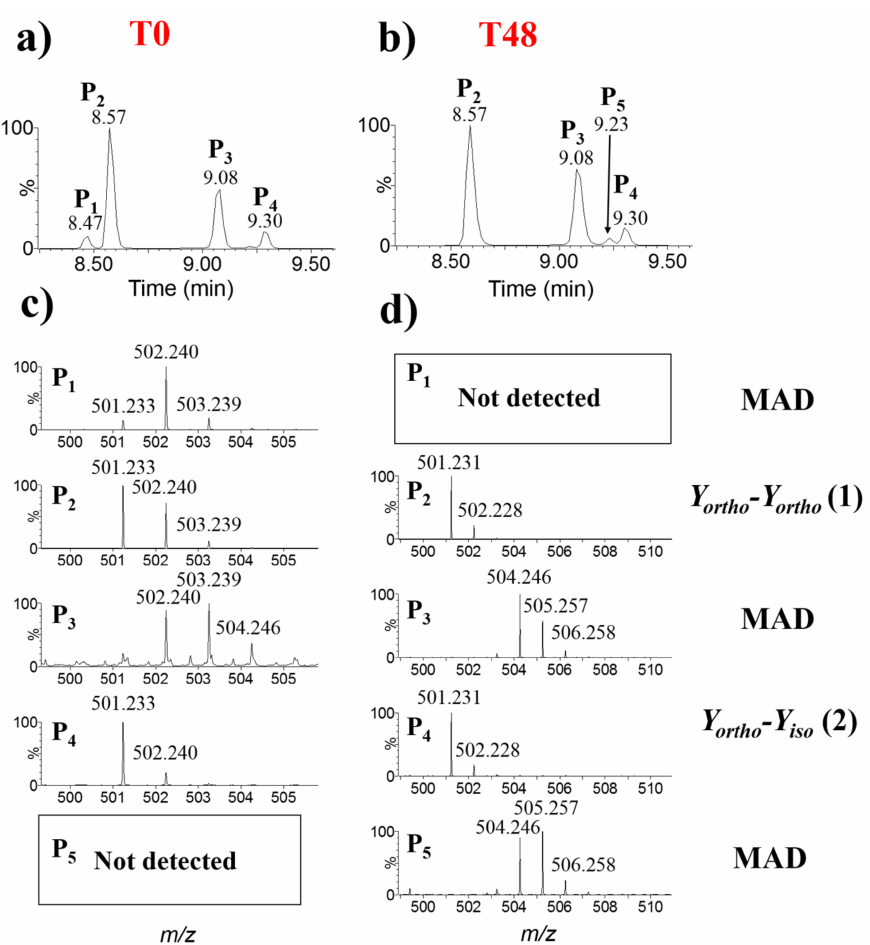
Figure 4. Oxidation of N-Acetyl-L-tyrosine ethyl ester (Ac-Y-Et) at 40 Gy in N 3 • production conditions. Extracted ion chromatograms m / z 501.23 ± 0.05 [M + H] + after oxidation in H 2 O at ( a ) T0 (0 h) and ( b ) T48 (48 h). Full scan MS spectra extracted at RT of dimers after oxidation in D 2 O at ( c ) T0 (0 h) and ( d ) T48 (48 h). Minor peaks in mass spectra arise from isotopic